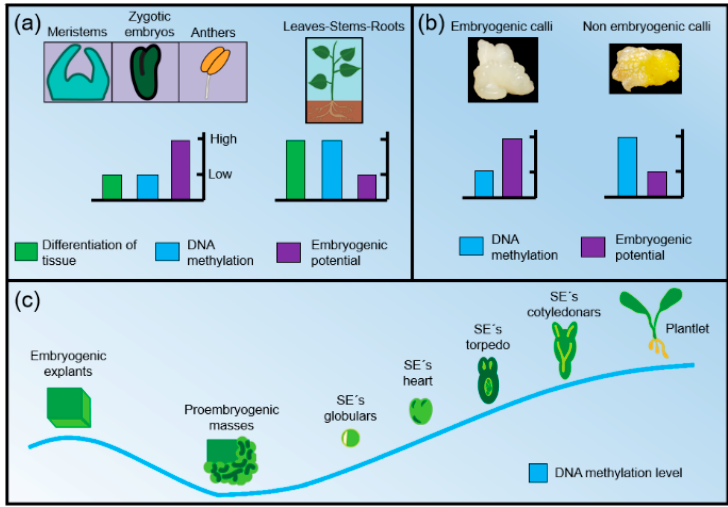
Figure 3. ( A ) Relations between levels of cell differentiation, DNA methylation and embryogenic potential between different kinds of plant tissues used as explants; ( B ) differences in DNA methylation and embryogenic potential between embryogenic and non-embryogenic callus; ( C ) dynamics of DNA methylation levels throughout the SE